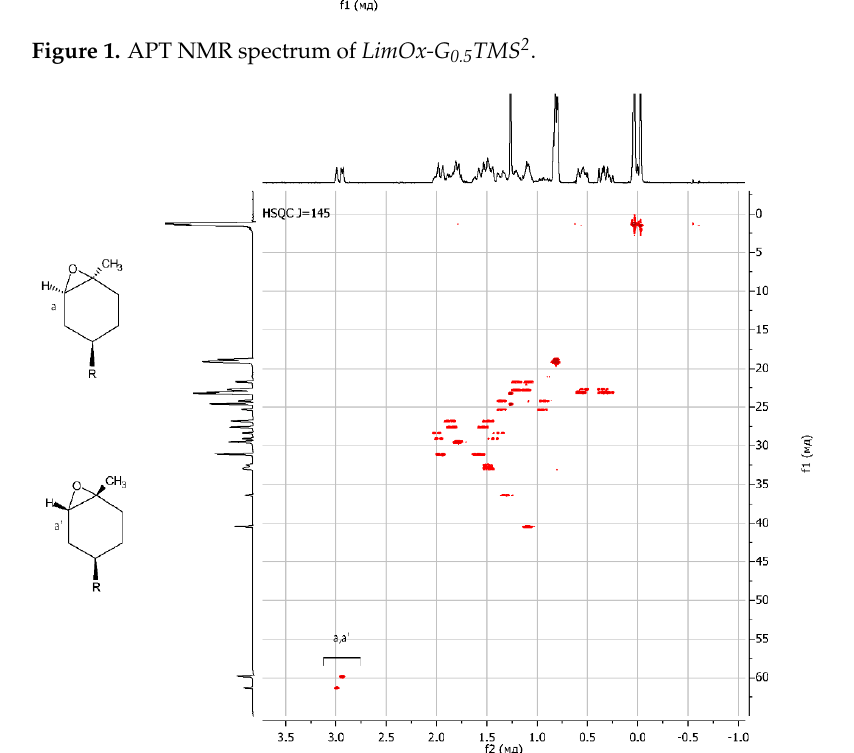
Figure 2. { 1 H; 13 C} HSQC NMR spectrum of LimOx-G 0.5 TMS 2 .